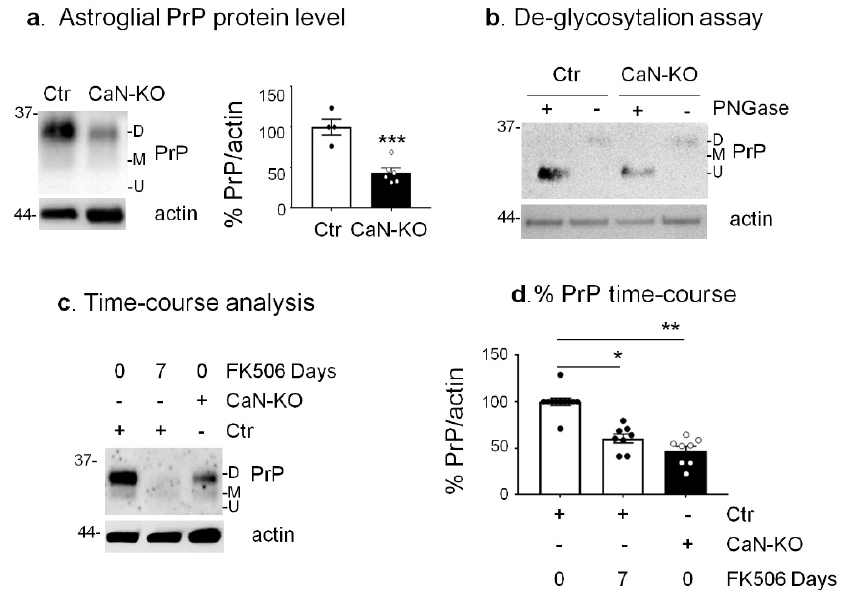
Figure 1. Analysis of PrP C expression in Ctr, FK506-treated Ctr and CaN-KO primary hippocampal astrocytes. ( a ) Expression levels of PrP C in Ctr and CaN-KO astrocytes. WB analysis of protein extracts with anti-PrP C 12B2 and anti-actin antibodies and quantification of actin-normalized PrP C levels expressed as percentages of Ctr. Data are the means ± SEM of Ctr ( n = 4) and KO ( n = 6) replicate astrocyte cultures. *** p < 0.001 by unpaired t -test. ( b ) Deglycosylation assay in Ctr and CaN-KO astroglial lysates. Ctr and CaN-KO astroglial lysates were treated with PNGase F and analysed by WB with anti-PrP 12B2 and anti-actin antibodies. ( c ) Time-course analysis with FK506 in Ctr and CaN-KO astrocytes. Ctr astrocytes were left untreated or treated with FK506 200 nM for 7 days and analyzed by WB with anti-PrP 12B2 and anti-actin antibodies, along with CaN-KO astrocyte lysates. ( d ) Quantification of actin-normalized PrP C levels in WB like the one shown in ( c ). Data are the means ± SEM, ( n = 6–11); * p < 0.05, ** p < 0.01 vs. Ctr by one-way Anova, multiple comparison Kruskal–Wallis